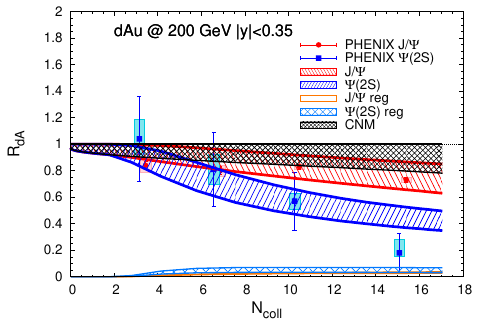
Figure 3 . Centrality dependent R d A for J= (red bands) and (2 S ) (blue bands) in 200 GeV d -Au collision, compared with experimental data [8]. The orange (light blue) band is for the J= ( (2 S )) regeneration component. The CNM e(cid:11)ect only (black band) represents the uncertainty due to shadowing (via an absorption cross section of 0-2.4 mb) and is the major source of uncertainty for the colored